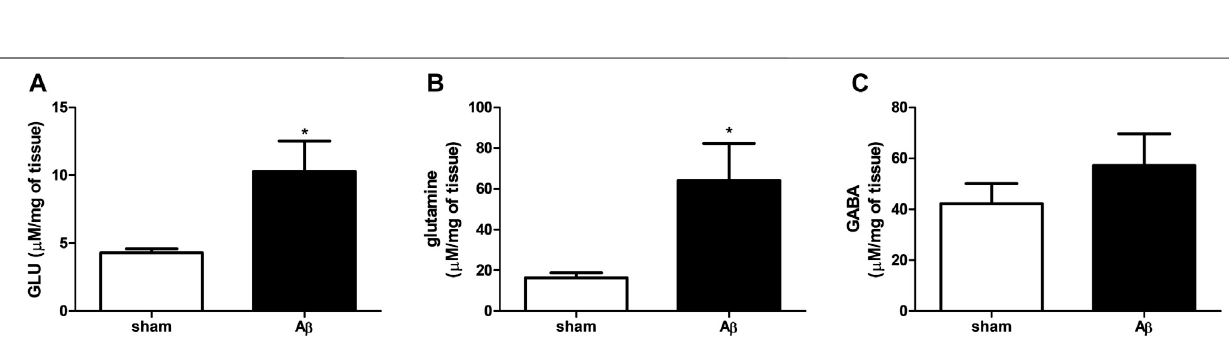
Frontiers in Pharmacology |